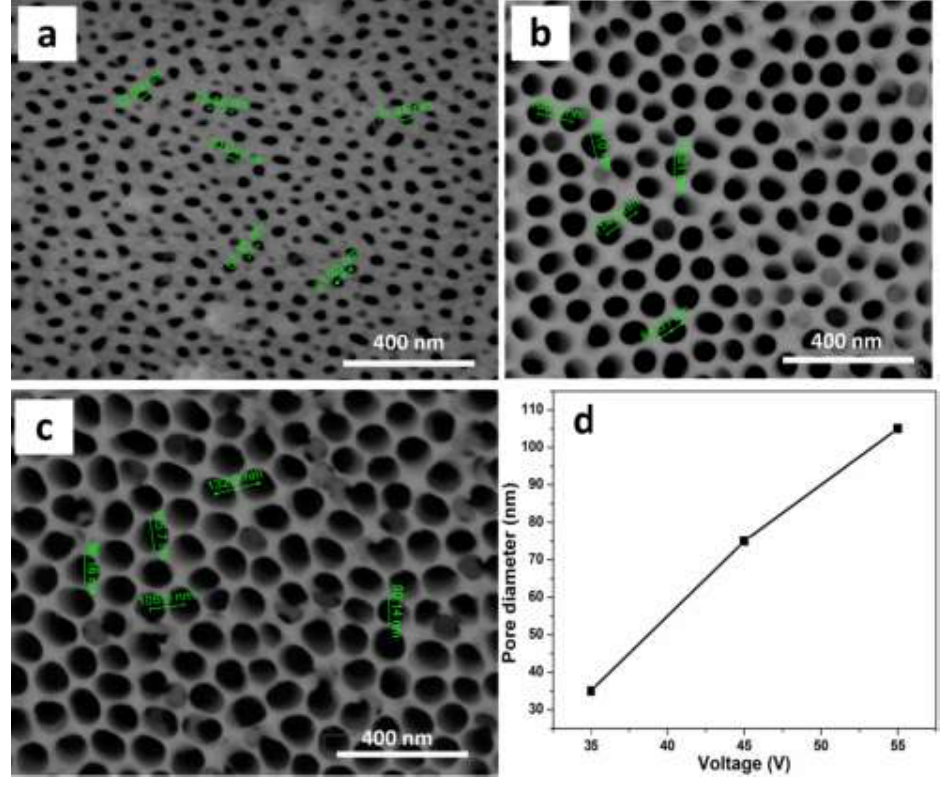
Figure 2: (a), (b) and (c), The AAO patterns are seen in top view in FESEM images. AAO patterns were made under the following conditions: first-step anodization acquired 10 minutes, pore widening acquired 30 minutes, and anodizing voltages were 35, 45, and 55 V, respectively. Figure (d) illustrates the pore diameter as a function of